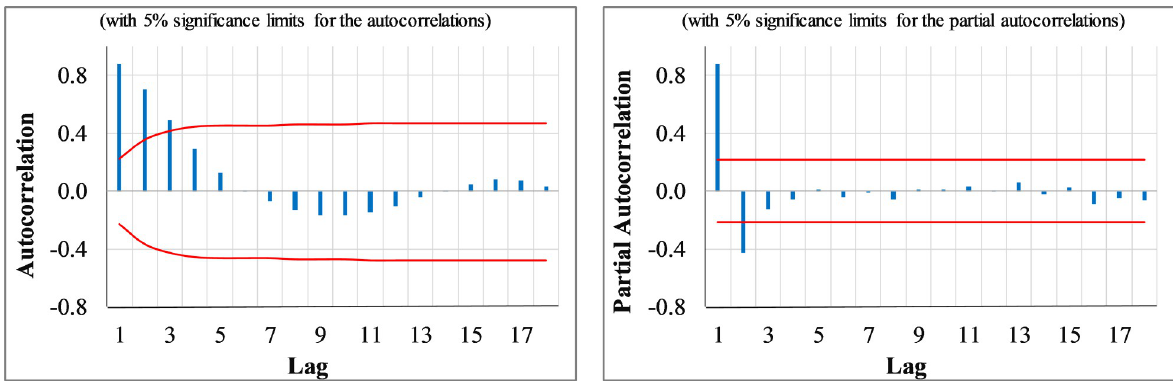
Fig 4. The ACF and PACF plots of the original weekly new COVID deaths time